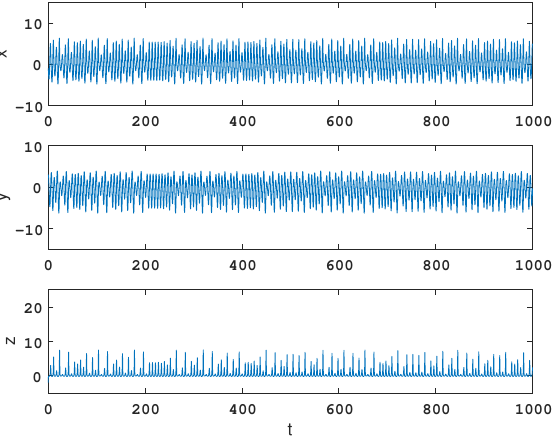
Figure 8. The chaos diagram of Rössler’s system at initial condition x 0 = [ − 1,3, − 2 ] T . Also, at α = 0.2, J 0.2 = 0.8 ∗ ( t + 1 0.7604, and the response curve is in Figure 9.